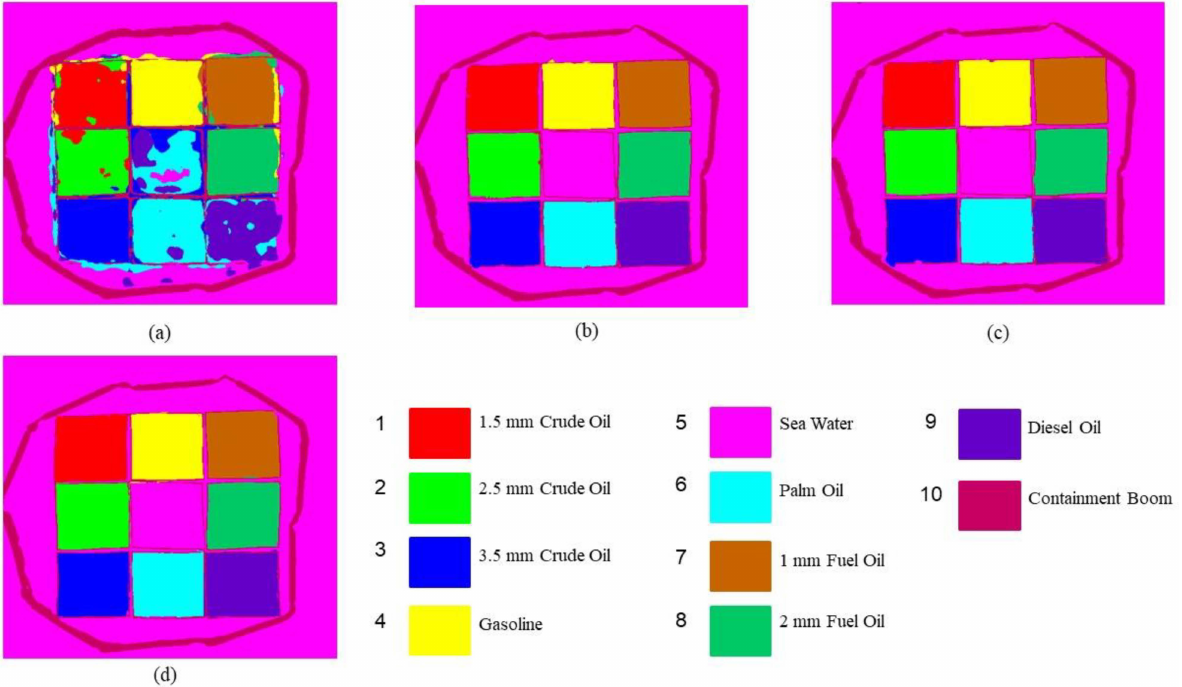
Figure 4. Identification results of the oil type data. ( a ) CGCNN, ( b ) SSRN, ( c ) A2S2KResNet, ( d )